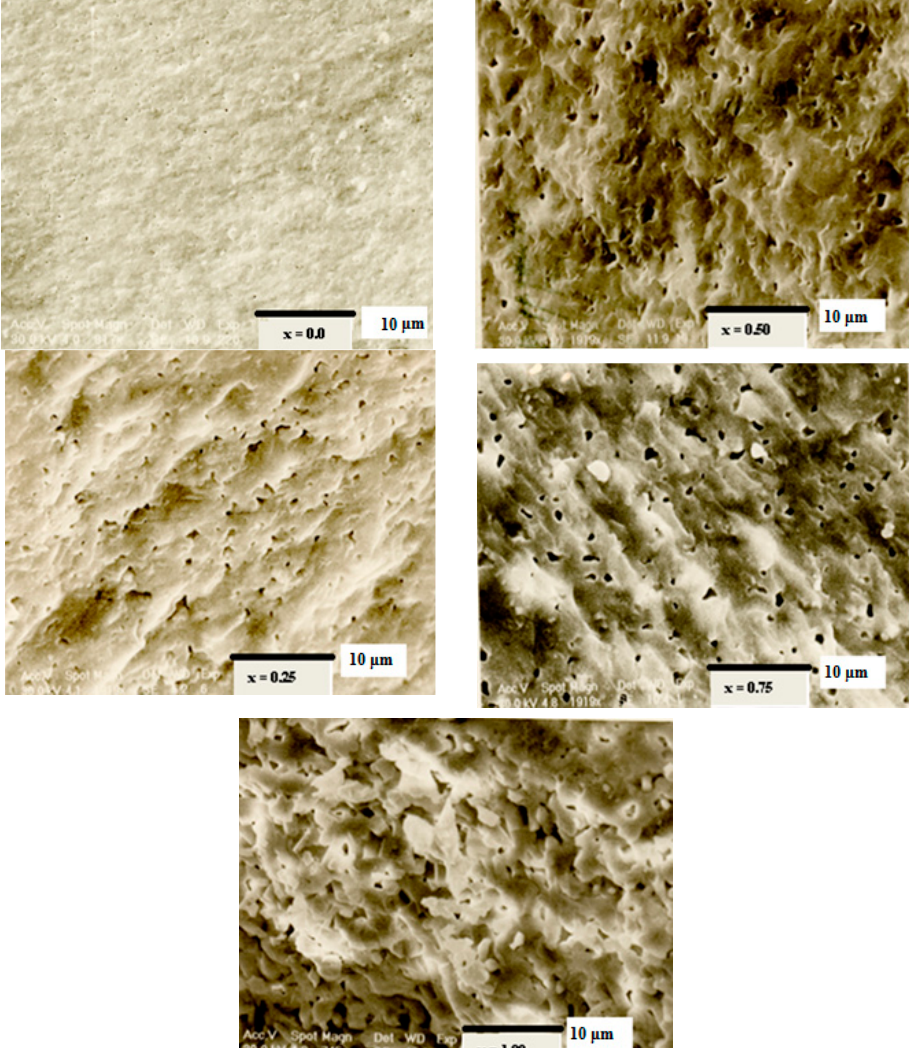
Figure 7. SEM micrographs of the fracture surfaces of the Ca 10 − x K x (PO 4 ) 6 F (2 − 2 x ) (OH) x for 0 ≤ x ≤ 1 samples sintered at 1050 °C for 1 h.